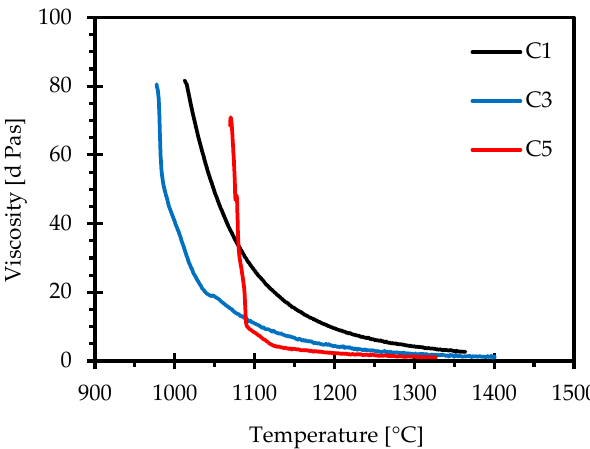
Figure 15. Viscosity–temperature curves of C1, C2 and C3 samples obtained from the rotating bob viscometer.